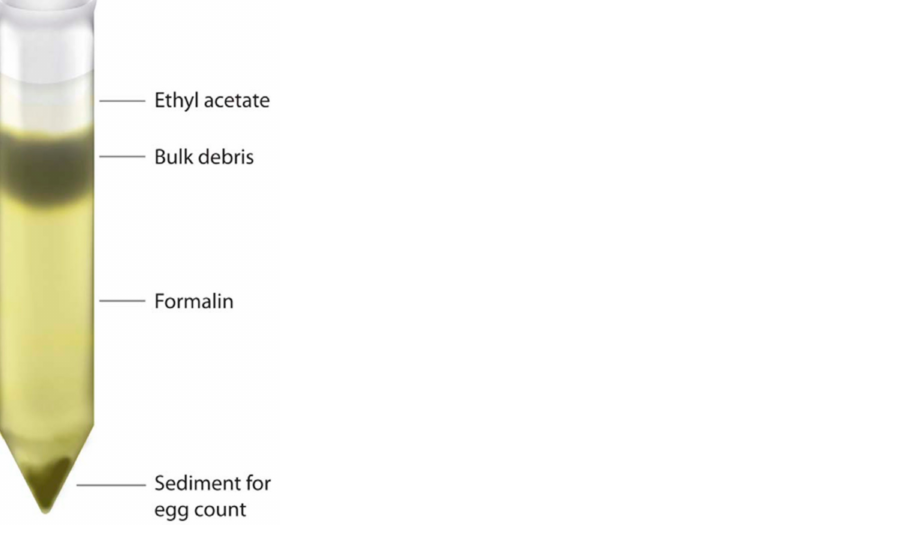
Figure 1. Layer of separation after the addition of ethyl-acetate and centrifugation. Reprinted from Xu et al. (2012)